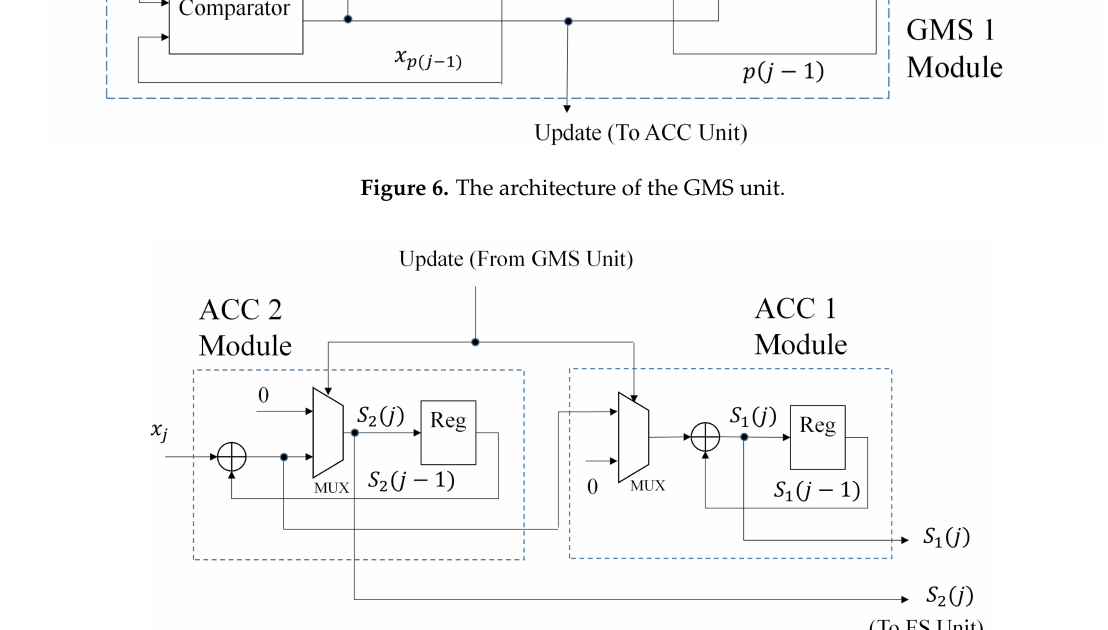
Figure 7. The architecture of the ACC